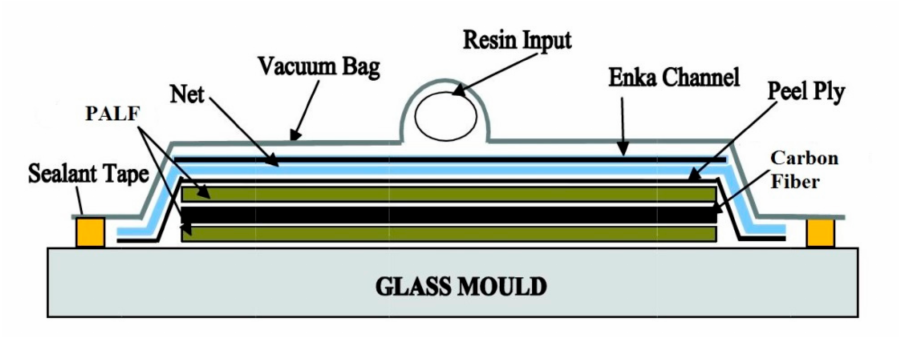
Figure 1. Schematic of the vacuum infusion